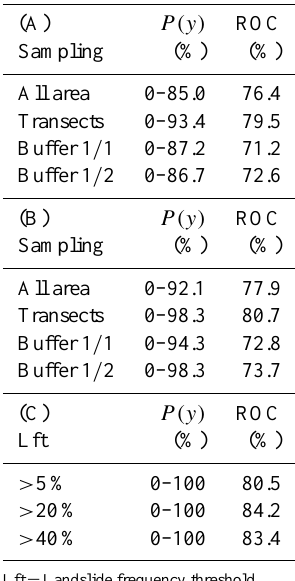
Table 2. Synthesis of P(y) values and validation of RL performed: (A) with square cells and grouped variables for all tested sampling area; (B) with square cells and dummy variables for all tested sam- pling area; (C) with slope units and dummy variables for all tested landslide frequency threshold (Lft): (A) Lft > 5%; (B) Lft > 20%; (C) Lft > 40%.